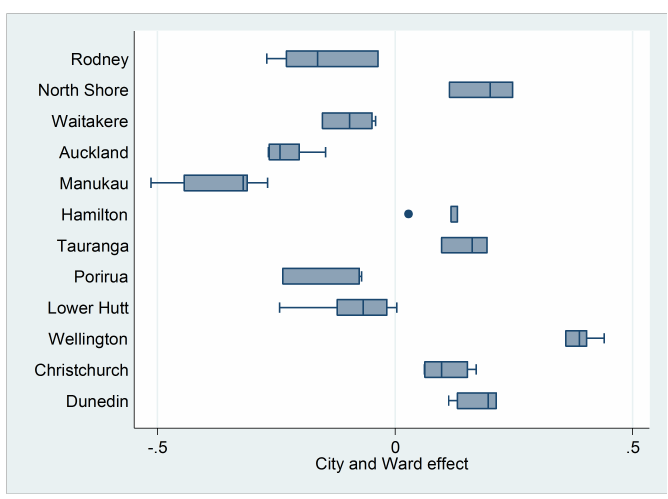
Figure 3: Ward to ward variation in urban pride within cities: predicted random intercepts by wards within cities. New Zealand